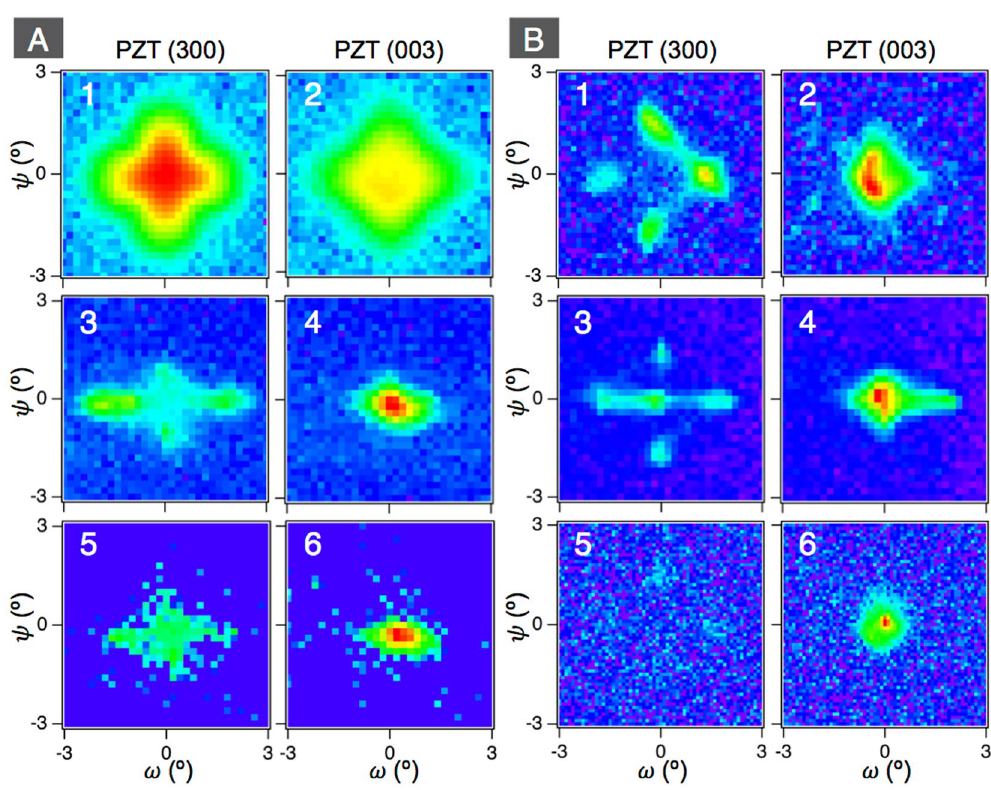
Figure 3. XRD ω - ψ maps for PZT (300) and (003) of the rods on LSCO/CeO 2 /YSZ-buffered on Si(100) ( A ) and Nb-STO (100) ( B ). 1 and 2, 3 and 4, and 5 and 6 show the films, the 2 μ m-wide rods, and the 1 μ m-wide rods, respectively. The maps for the rods on Nb-STO are quoted from ref. 29 (Copyright (2015) The Japan Society of Applied